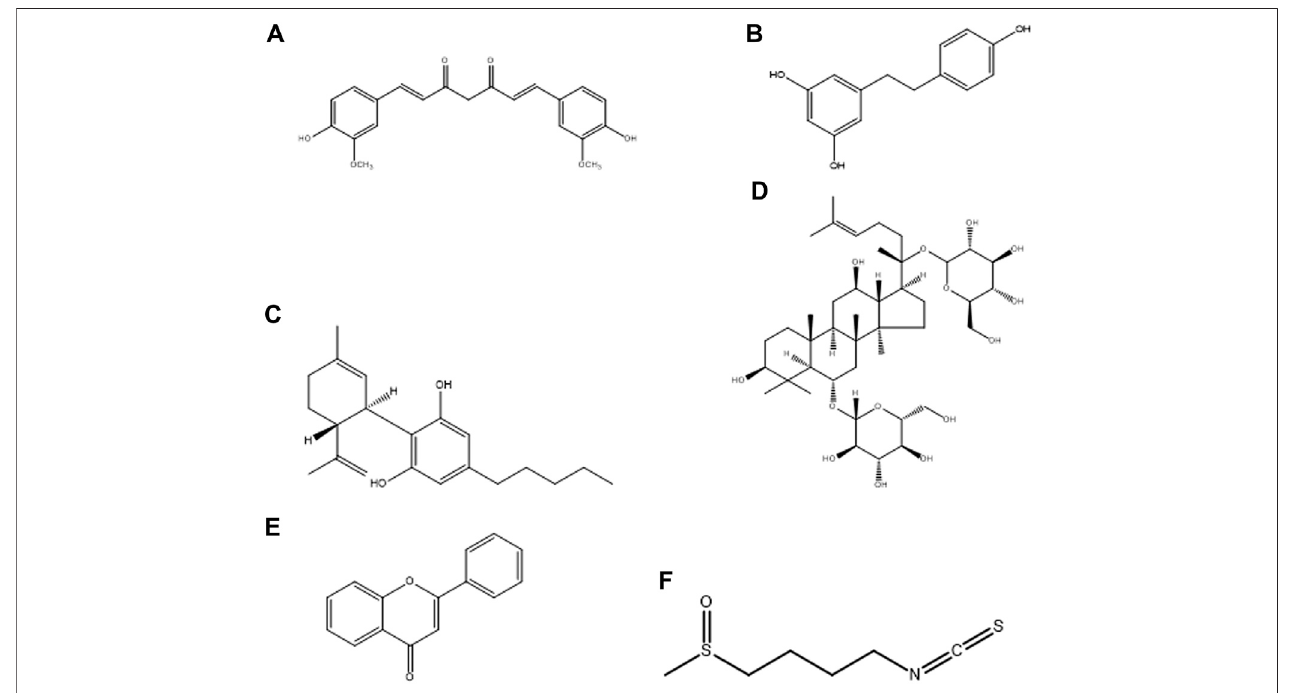
FIGURE 2 | Chemical structure of natural products, (A) Curcumin, (B) Resveratrol, (C) Cannabidiol, (D) Ginsenosides, (E) Flavonoids, and (F) Sulforaphane.